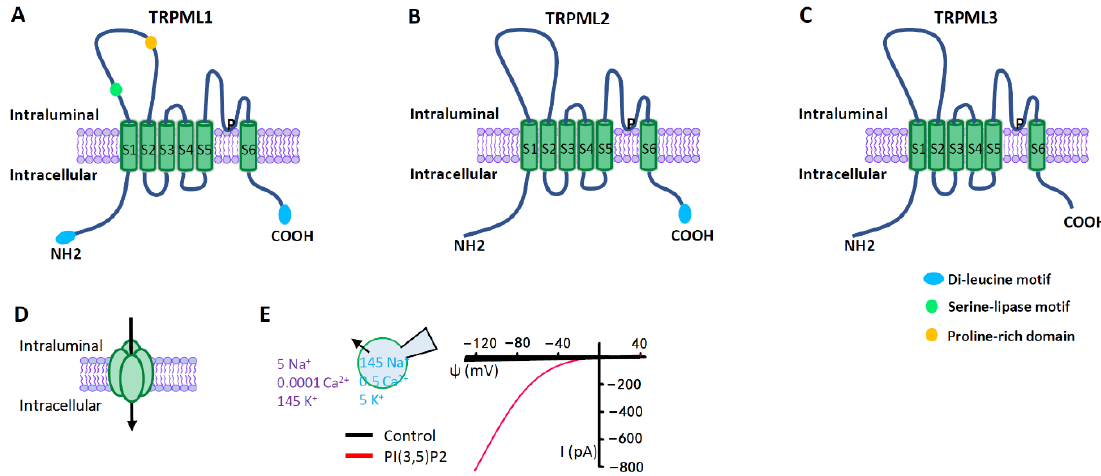
Figure 3. TRPML ion channels. ( A – C ) TRPML pore-forming subunit contains six transmembrane segments (S1–S6) and a putative pore region (P), with presumably cytosolic N- and C- termini. Distinct from other TRP channels, TRPMLs are characterized by a large extracellular (or intraluminal) loop between S1 and S2. There are dileucine motifs in TRPML1 and TRPML2 at their C- and/or N- termini to determine their intracellular endolysosomal localization. The endolysosomal localization of TRPML3 is determined by its heteromultimerization with other TRPMLs. ( D ) Functional TRPMLs are tetramers. ( E ) TRPMLs currents measured using lysosome-patch-clamp method. Physiological asymmetric solutions are used. The bath solution (cytosolic) contains (in mM) 145 K + , 5 Na + , 0.0001 Ca 2+ , and pH 7.2. Pipette solution (luminal) contains (in mM) 145 Na + , 5 K + , 0.5 Ca 2+ , and pH 4.6. TRPMLs are activated by cytosolic PI (3,5) P2 (1 µM), a lysosome- specific phosphoinositide. TRPMLs are inwardly (cation flowing from the lumen to the cytosol) rectifying channels permeable to cations. Given the topology of the TRPML proteins at the lysosomal membrane and the electrical properties of the lysosome, TRPML opening leads to Ca 2+ and Na + release from the lysosome to the cytosol.